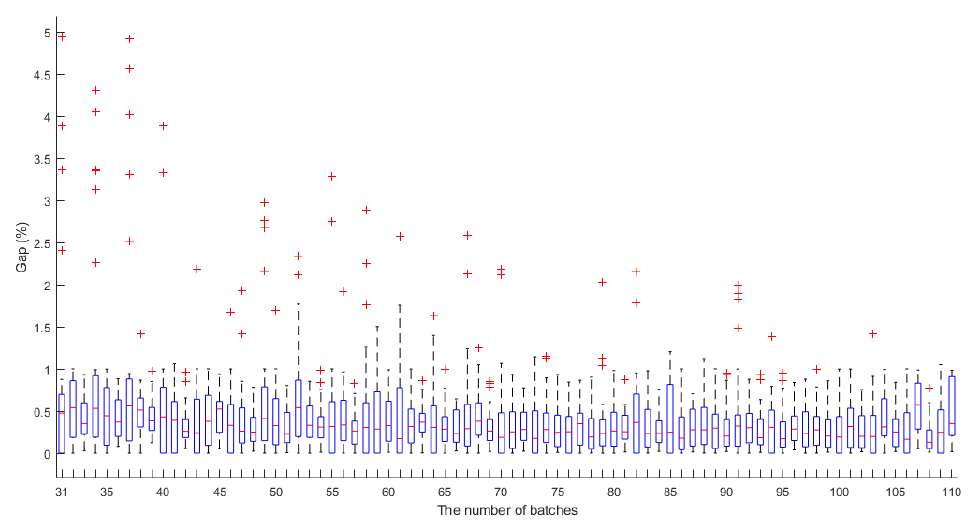
Figure 5. The boxplots for all values of [31, 110].